Question: Judging by this figure, is the value going up or going down?
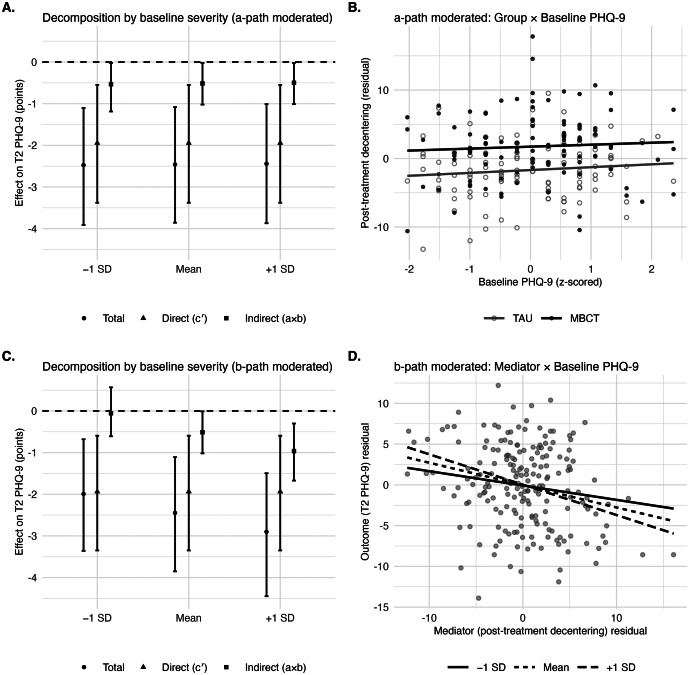
Answer: increasing